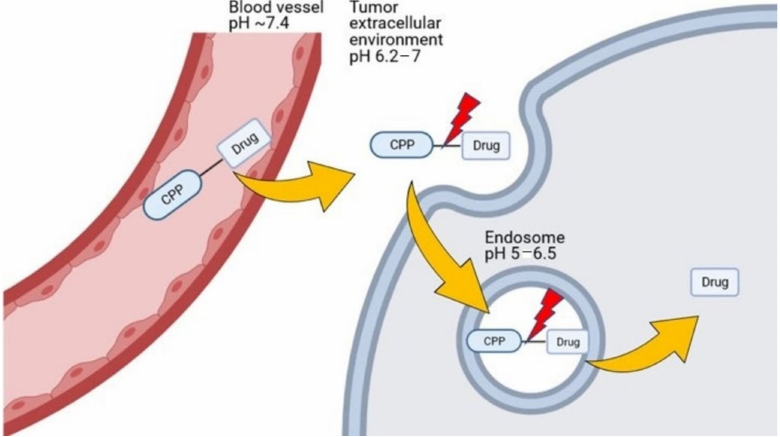
Figure 4. Targeting ability of an acid-sensitive linker (the lightning bolt in red represents cleavage of the linker either extracellularly or within acidic environment in